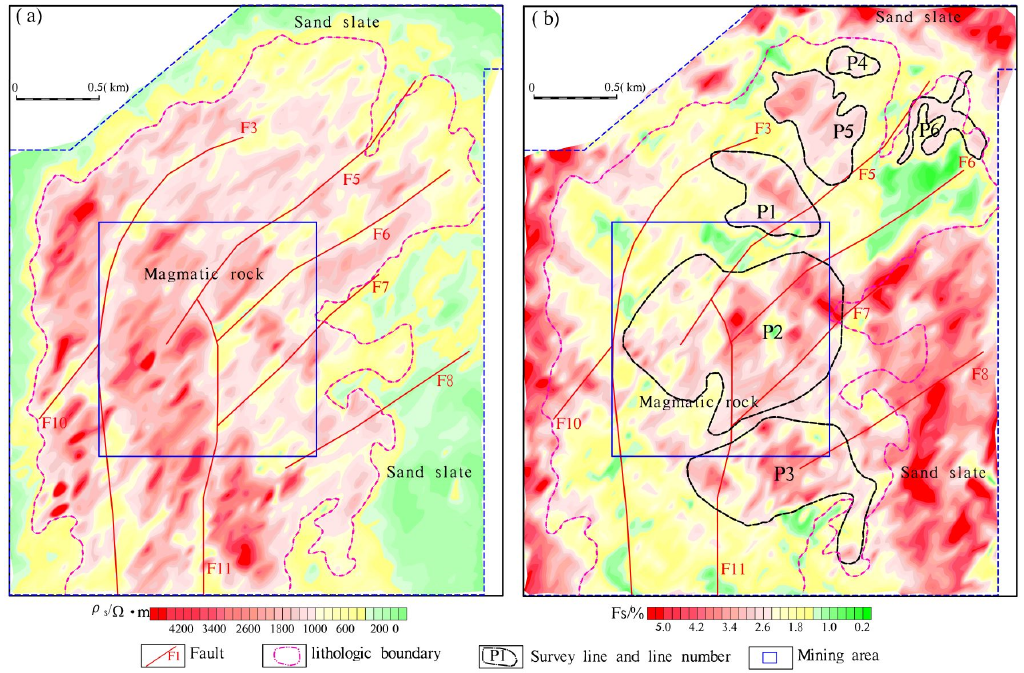
Figure 4. Induced polarization (IP) anomaly diagram of the Nanpo gold deposit: ( a ) resistivity; ( b ) amplitude frequency.